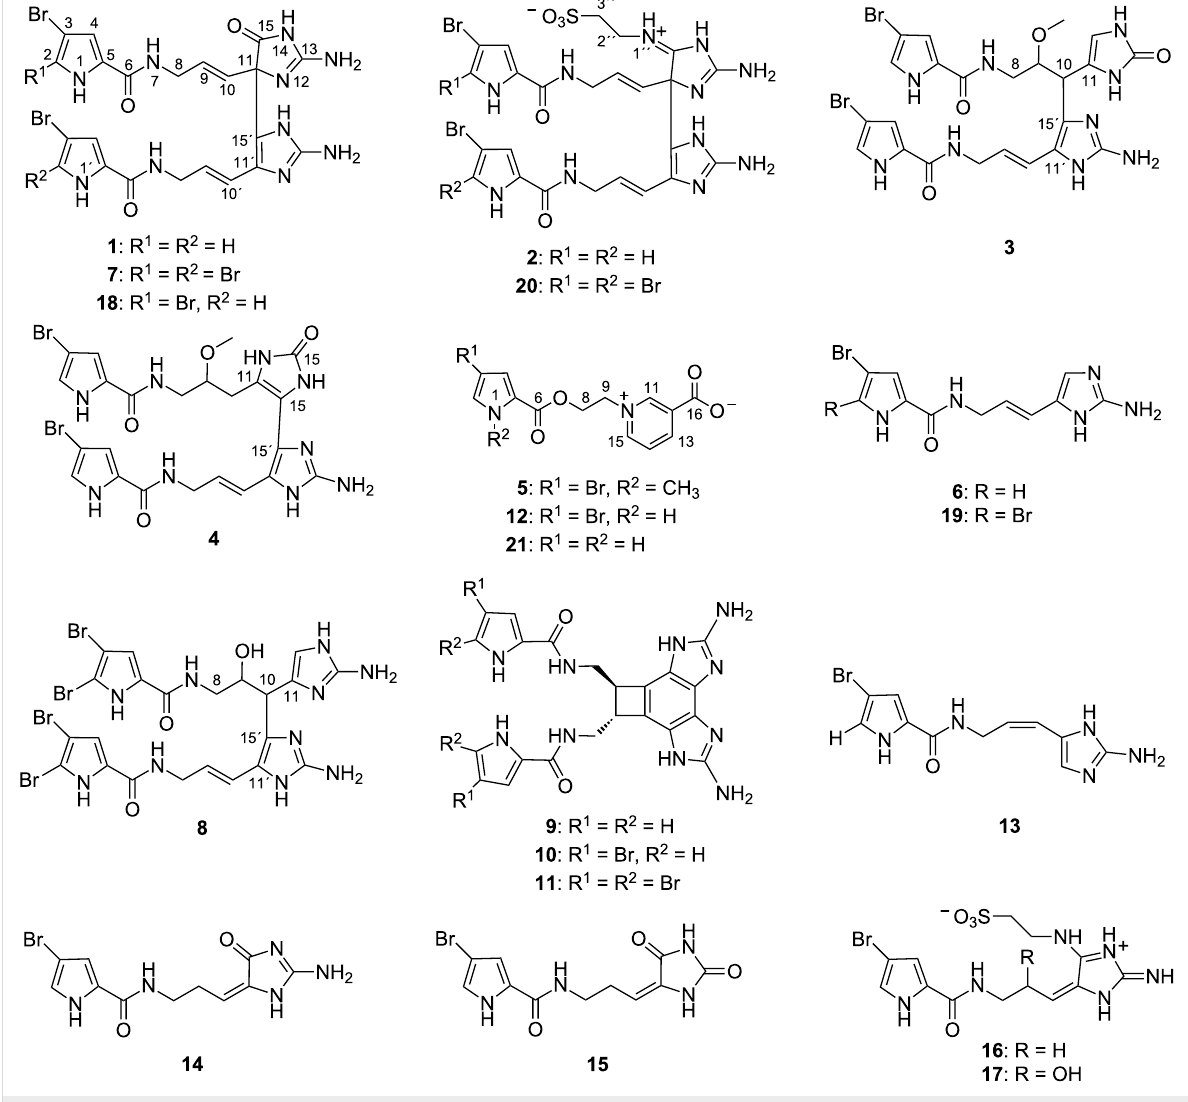
Figure 1: Selected pyrrole-imidazole alkaloids ( 1 – 4 , 6 – 11 , and 13 – 20 ), and agelongine analogues ( 5 , 12 , and 21